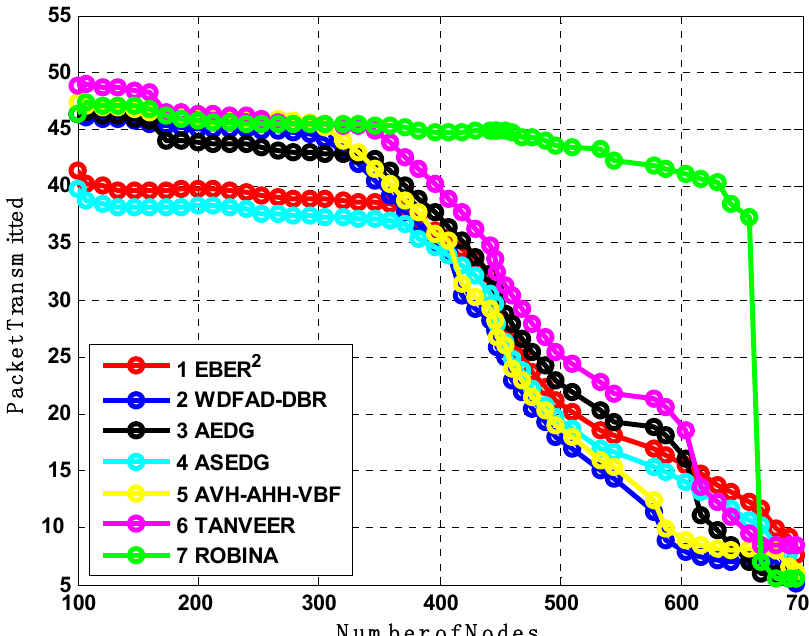
Figure 8. Analysis of Packet transmission with baseline schemes.